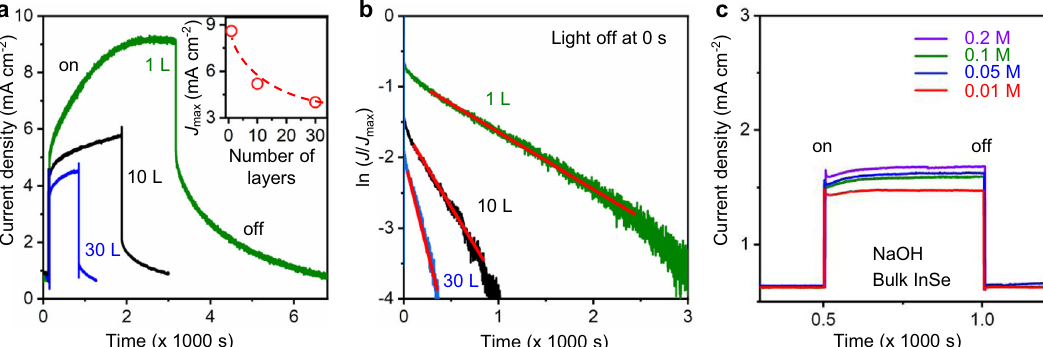
Fig. 3 Persistent photocurrent density in the InSe/Gr photoanode. a Current density as a function of illumination time for InSe with various thicknesses. Inset shows the observed J max as a function of the InSe thickness. b Photocurrent decay for InSe with various thicknesses. The time point at which the light ceased is de fi ned as t = 0 for each sample. The red lines are the best fi t using Eq. (2). c Temporal dependence of the bulk InSe/Gr anode with various NaOH